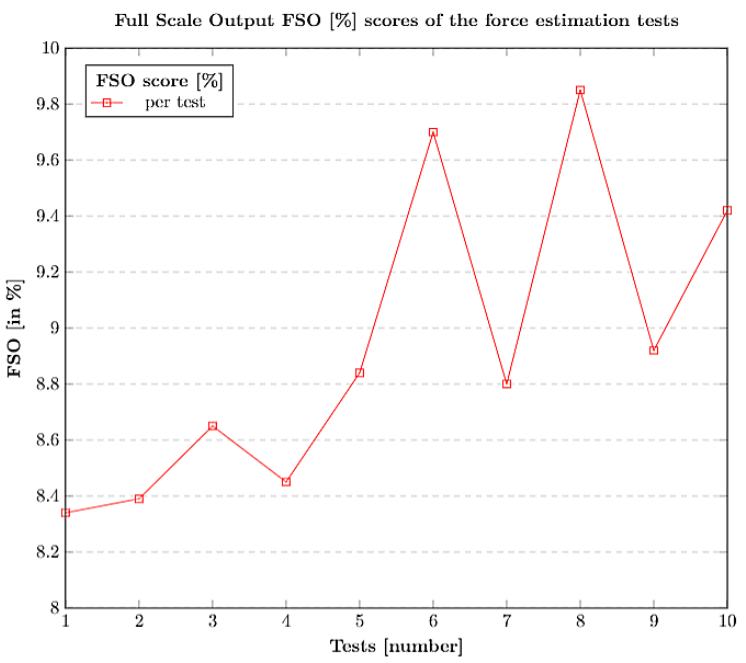
Figure 16. Full Scale Output (FSO) (%) output scores for force estimation